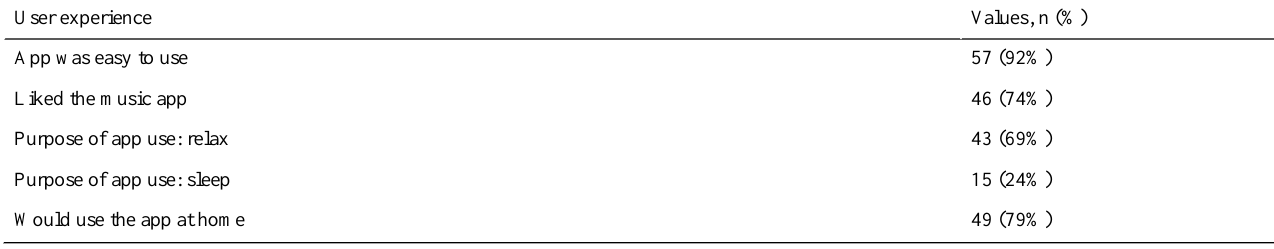
Table 2. Summary of the exit survey impressions of the Unwind App